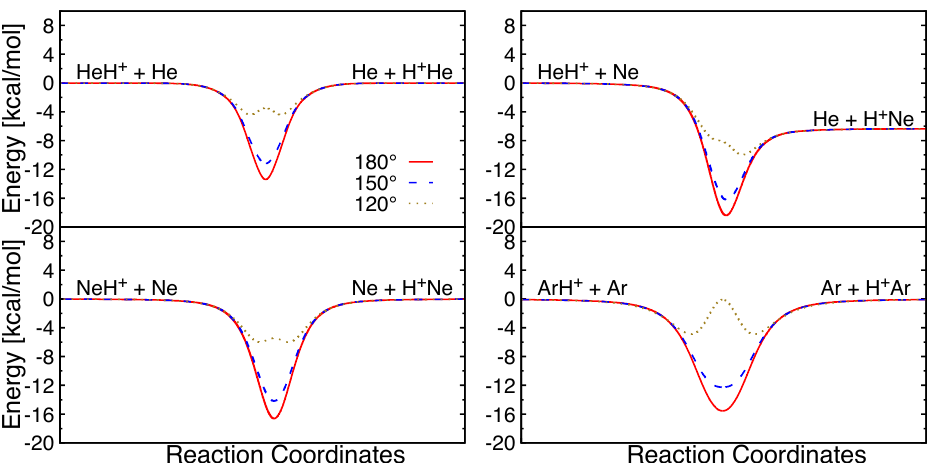
Figure 3. Minimum energy pathways along different attacking angle (Rg-H-Rg (cid:48) ) for different reactive collision